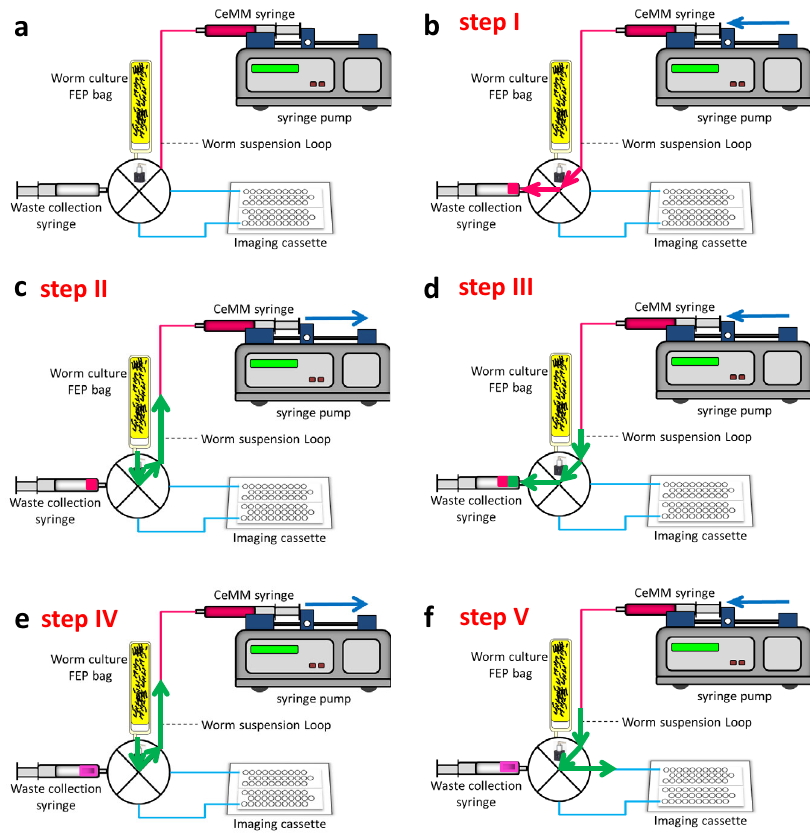
Fig. 5 Schematic diagram of protocol of loading worms into NemaFlex-S device using the Worm Loading Apparatus. a Shows the schematic of the worm loading apparatus. ( b ) Step I: priming of the valve with CeMM, fl ow will be from CeMM media syringe to waste collection syringe. ( c ) Step II: aspirating a speci fi ed worm aliquot from worm culture bag to worm suspension loop. d Step III: priming of the valve with worm suspension, fl ow is from suspension loop to waste collection syringe. ( e ) Step IV: taking a speci fi ed worm aliquot (400 µL) from worm bag to suspension loop. ( f ) Step V: load the worms into A side of the NemaFlex-S device. Repeat step IV and step V to load the worms into the B side of the NemaFlex-S